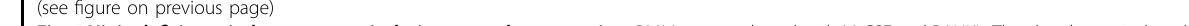
Fig. 6 Ninj1 de fi ciency induces apoptosis during osteoclastogenesis. a BMMs were cultured with M-CSF and RANKL. The absorbance induced by MTS was measured at 492 nm, and the relative cell population is shown as the mean ± SD ( n = 3, with triplicates in each experiment); ** P < 0.01. b BMMs were cultured with RANKL, and the relative cell growth was evaluated at the indicated time points and is shown as the mean ± SD ( n = 3, with triplicates in each experiment). c – e BMMs were cultured with M-CSF and RANKL. Cells were harvested and stained with FITC-Annexin V and 7AAD on the indicated days followed by FACS analysis. c Representative density plots at days 2 and 4. ( d ) FACS-determined statistical stacked bars ( n = 4). ( e ) The FACS-determined percent frequencies of Annexin V + cells are shown as the mean ± SD ( n = 4). (f – h) RAW264.7 cells were transfected with siScr or siNinj1 and cultured with RANKL. Cells were harvested and stained with FITC-Annexin V and 7AAD on the indicated days followed by FACS analysis. ( f ) Representative density plots at days 2 and 3 determined by FACS analysis. ( g ) FACS-determined statistical stacked bars ( n = 4). ( h ) FACS-determined percent frequency of Annexin V + cells. The data are shown as the mean ± SD ( n = 4); *** P <